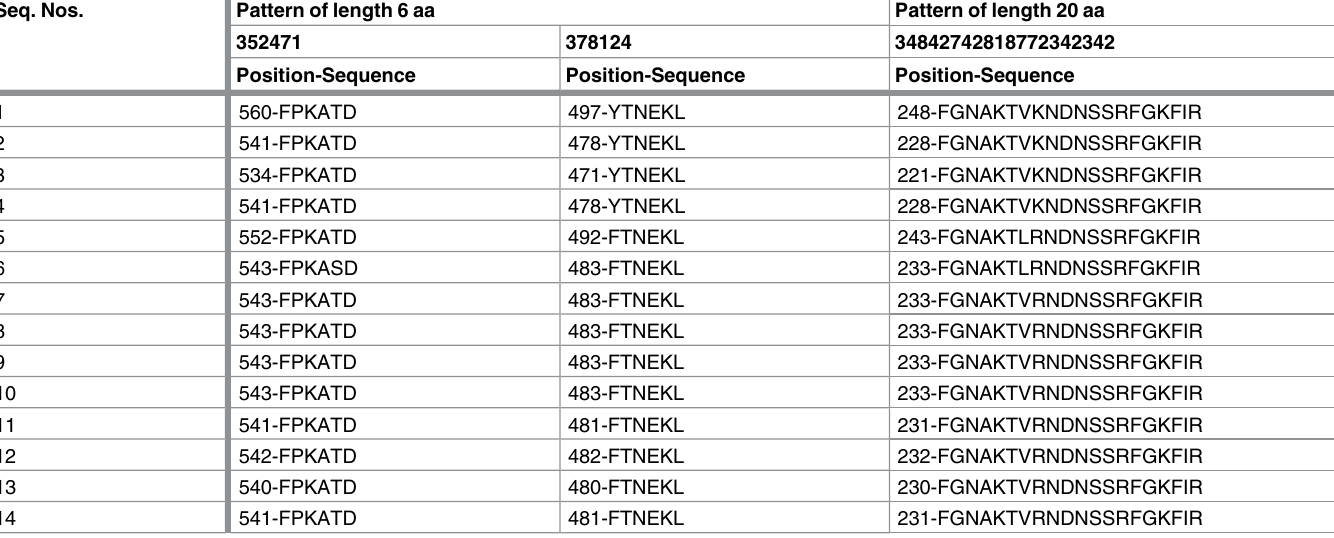
First two patterns of length 6 aa are without repeating of chemical groups (using Algorithm 2) and last pattern of length 20 aa are with the repeating of chemical groups (using Algorithm